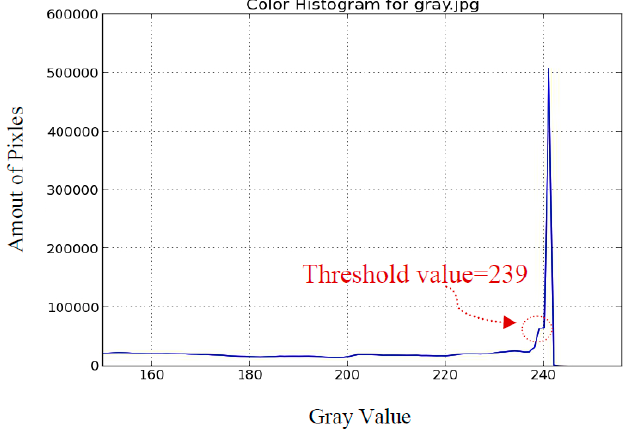
Figure 9. The histogram of the original image in Figure 5a.